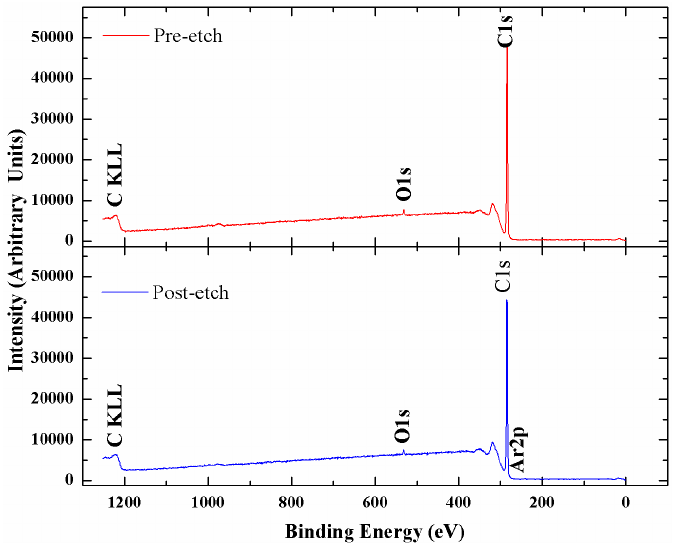
Figure 4. X-ray photoelectron spectrometer (XPS) survey scans of NSD film grown on Ti–6Al–4V utilizing a gaseous chemistry of 500 sccm of H of N 2